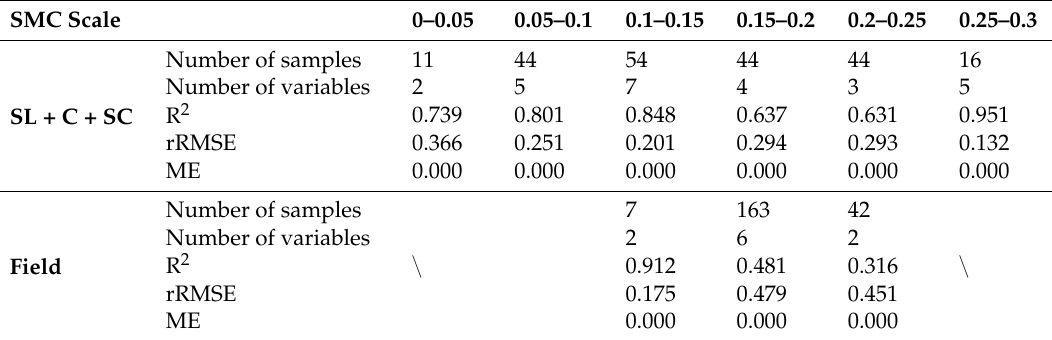
Table 6. Statistics for calibration results of M_SSC SMC models for soil salt concentration. The number of samples is shown for each calibration dataset. The number of variables are indicated for each of the stepwise regression equations. Not included is the constant